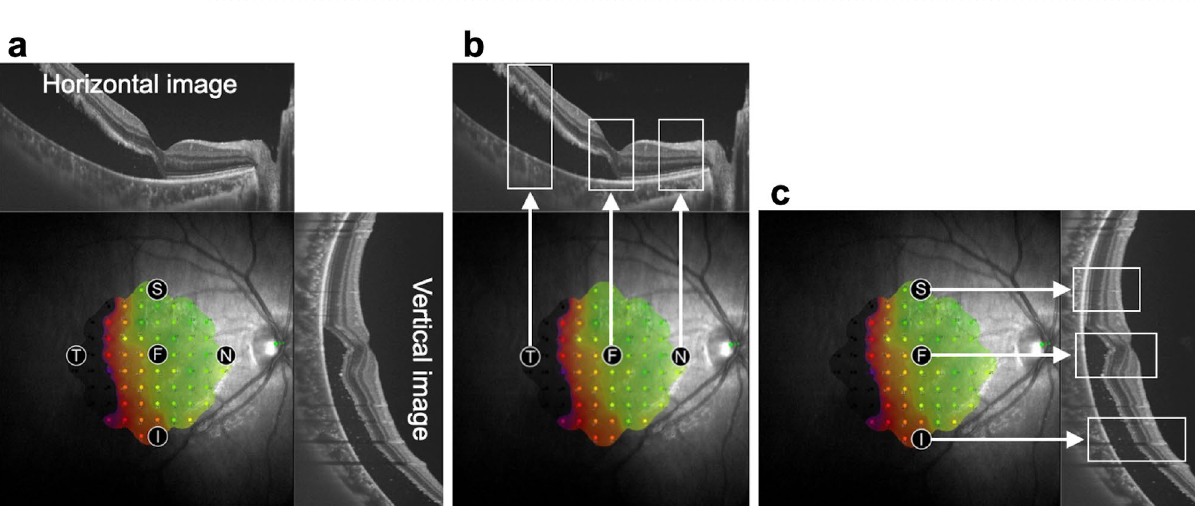
Figure 6. Analysis of retinal structures at the measurement points of retinal sensitivity. Fundus images obtained via Macular Integrity Assessment system and swept-source optical coherence tomography are superimposed ( a ). B-scan images corresponding to each measurement point [squares in ( b ) and ( c )] are examined to evaluate the presence or absence of retinal detachment and the continuity of the ellipsoid zone. F fovea, S superior, I inferior, T temporal, N